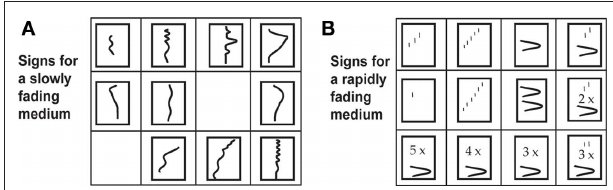
Figure 2 | examples of the sign systems studied by galantucci et al. (2010). The signs are placed in the location on the game map they indicated. (A) Non-combinatorial system developed for the slowly fading medium. Each sign is composed of a distinct basic form. (B) Highly combinatorial system developed for the rapidly fading medium. Every sign contains at least one basic form that is present in one other sign. Forms are sequenced in time. (Adapted from Galantucci et al.,